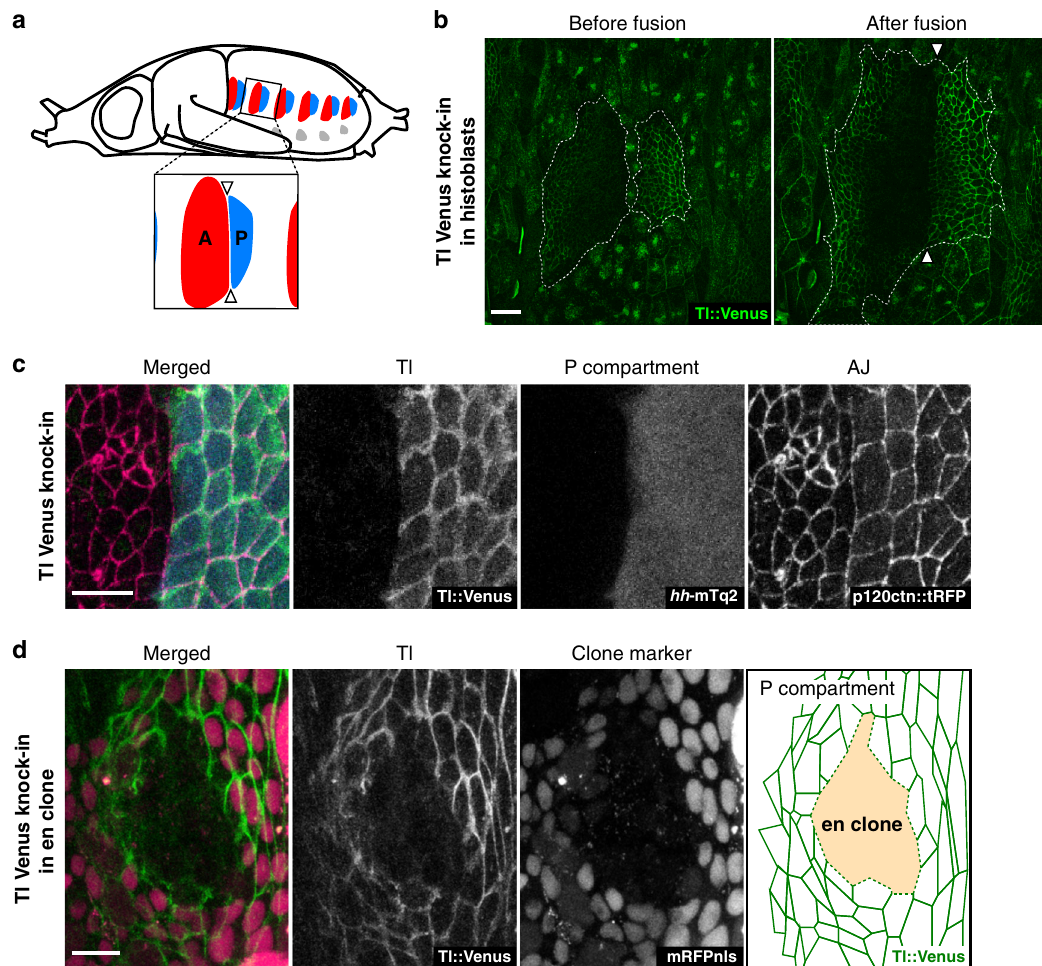
Fig. 1 Toll-1 is expressed in P histoblasts under the control of engrailed . a Schematic depicting anterior (red) and posterior (light blue) histoblast nests in the epidermis of the Drosophila pupal abdomen. The boxed region highlights abdominal segment 2, and arrowheads point to the AP boundary. b Tissue wide expression pattern of Tl using fl uorescently tagged endogenous Tl protein. Arrowheads point to the AP boundary. Anterior is to the left and posterior is to the right unless otherwise stated in this and all the following fi gures. Presented data are a representative image of n = 10 animals. Scale bar: 30 μ m. c Tl protein localization visualized by Venus knock-in (green). Adherens junctions and P histoblasts were labeled with p120ctn::tagRFP (magenta) and hh :: mTurquoise2 (cyan), respectively. Presented data are a representative image of n = 10 animals. Scale bar: 10 μ m. d Mosaic analysis of Tl expression in engrailed ( en ) mutant cells. Tl expression was monitored with the Venus knock-in (green). Cells mutant for en were labeled with the loss of the marker expression, a monomeric red fl uorescent protein with nuclear localization signal (mRFPnls) (magenta). Presented data is a representative image of n = 5 clones. Scale bar: 10 μ